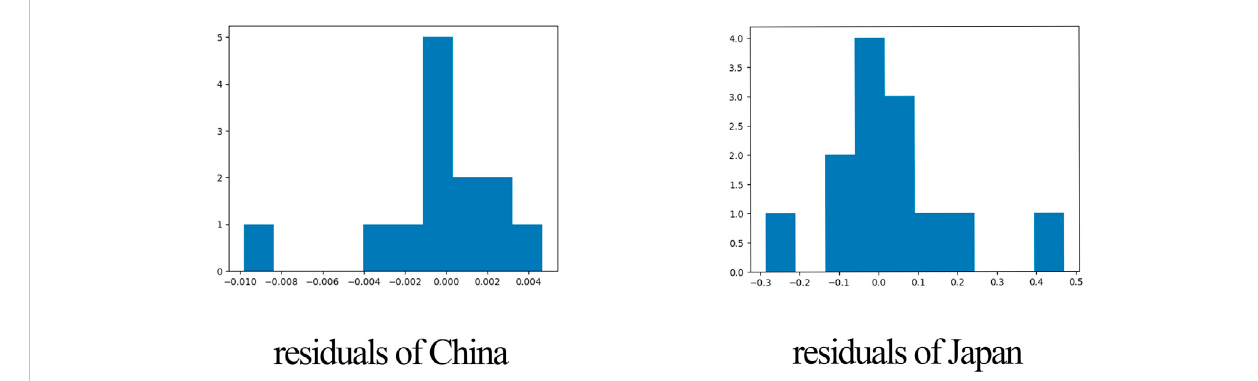
FIGURE 3 Histogram of residuals in China and Japan.